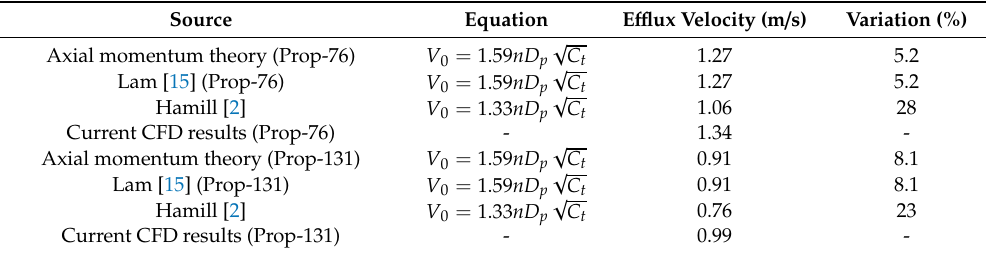
Table 3. Comparison of current study and previous studies on e ffl ux plane.